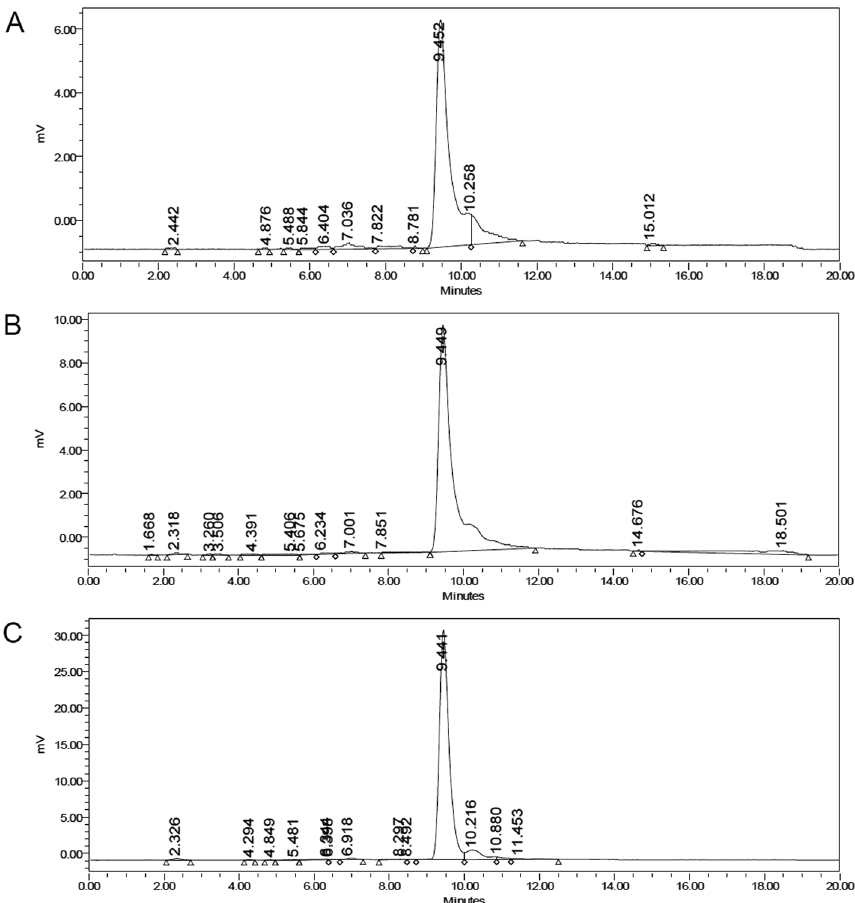
Fig. 3 Typical radio‑chromatograms after injection of 20 µL of [ 177 Lu]Lu‑PSMA‑I&T dissolved in A 0.1 mM octreotide, B water, or C 0.7 mM PSMA‑I&T. Note the differences in scale of the y‑axis, which is adjusted to the height of the main peak